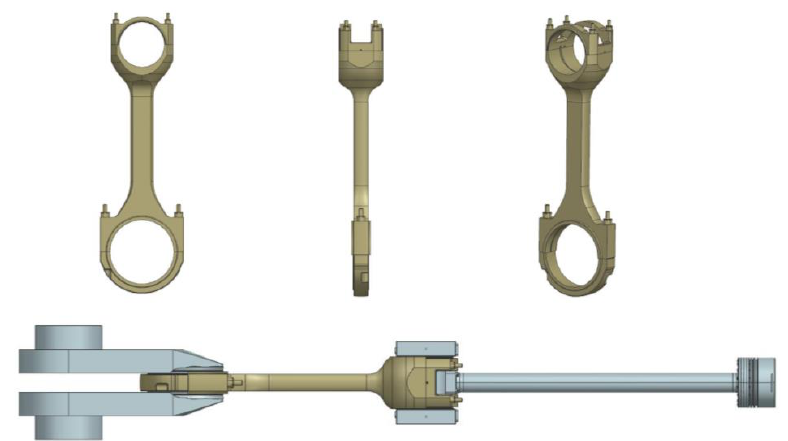
Figure 2. Crank connecting rod mechanism model.